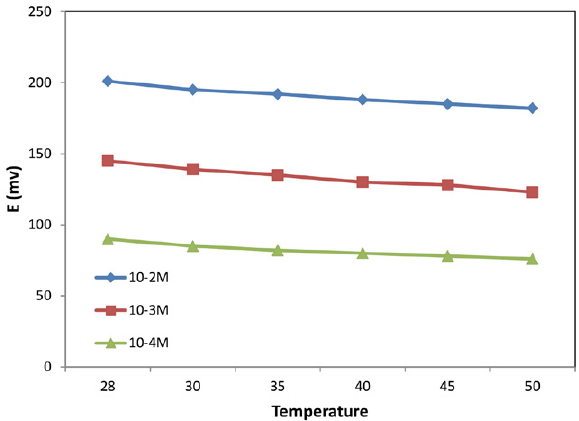
Fig. 9. Effect of temperature on the response of Lab sensor 2a